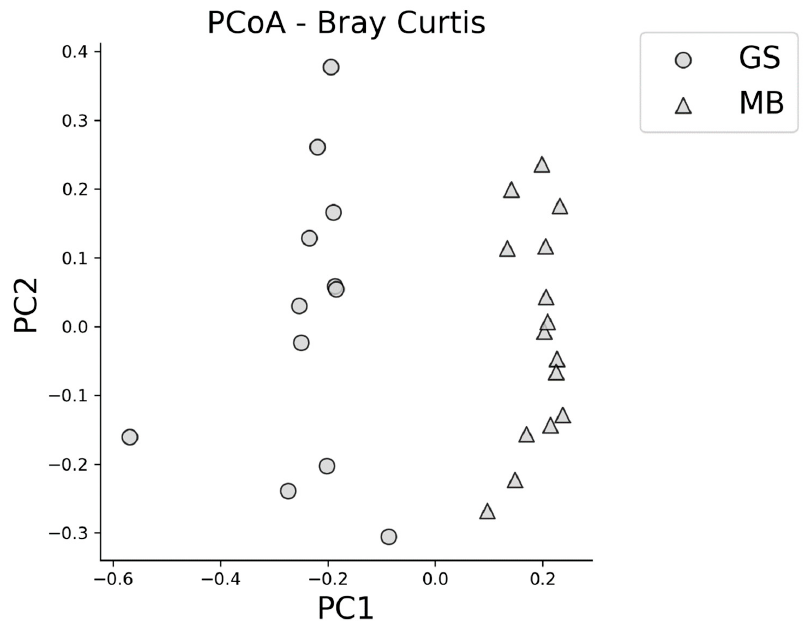
Figure 2. Beta diversity of the two study groups. Bray-Curtis beta diversity and Principal Coordinates Analysis (PCoA) the inter-sample variation highlighted a significant separation between the structural composition of the gut microbiota among study groups. (GM = German Shepherd, MB = mixed breeds).